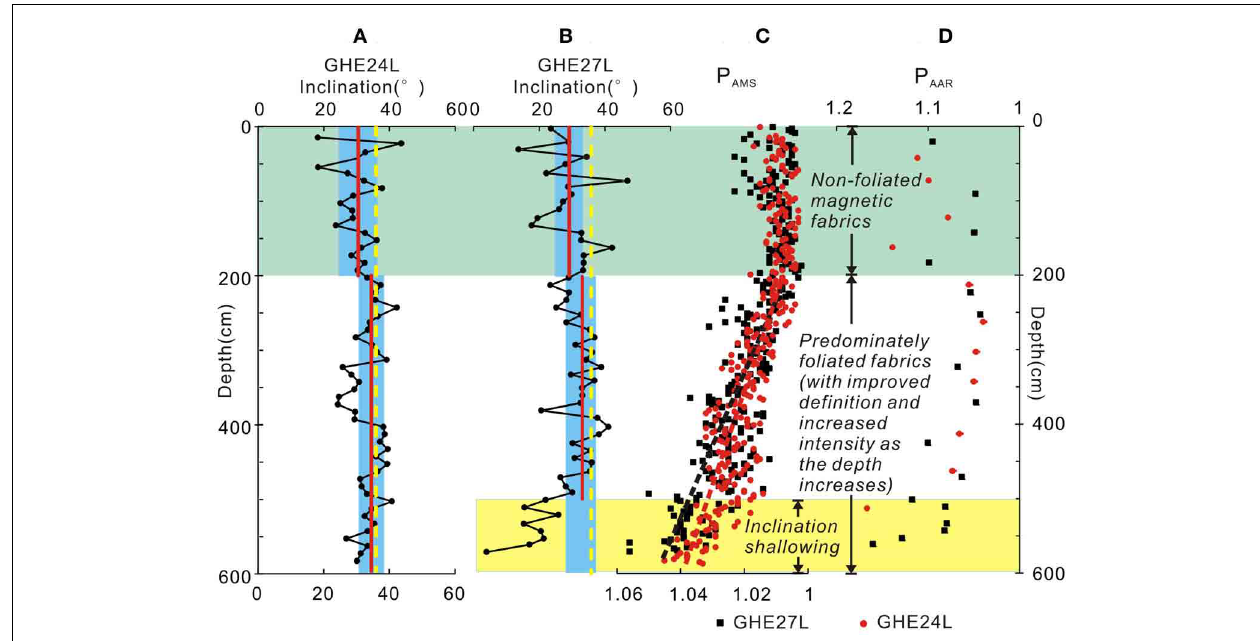
FIGURE 8 | Comparison of down-core variations in the inclinations of ChRMs (A,B) and changes in both AMS (C) and AAR (D) of Cores GHE24L and GHE27L. The red solid lines and the yellow dashed lines in (A,B) indicate the mean inclinations of the